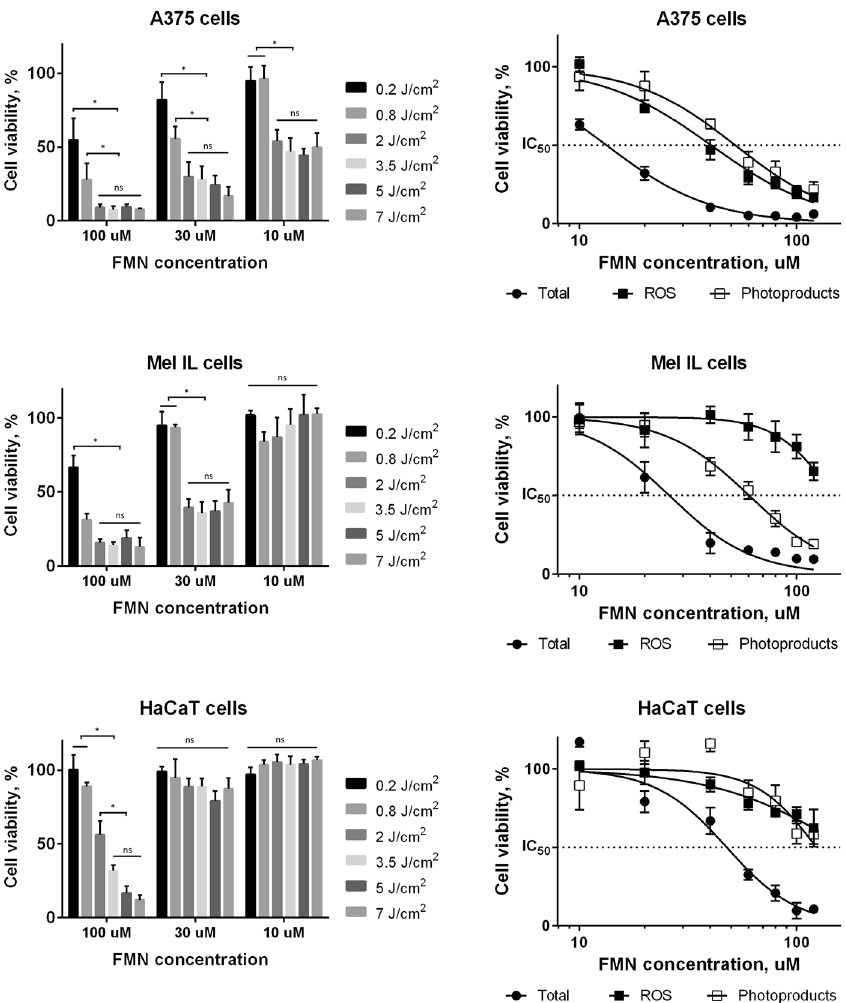
Figure 2. Viability of Mel IL, A375, and HaCaT cells after FMN photoactivation in exposure-dependent (left column) and FMN concentration-dependent at 5 J/cm 2 (right column) manners, 48 h incubation after irradiation with 450 nm. ROS and FMN photoproducts toxicities were measured both separately (black and blank squares, respectively) and in total (black circles). Cells without any treatment were used as controls and taken as 100%. MTT assay, the data are the mean ± SD from at least three replicates. Statistical analysis was performed using non-parametric Mann-Whitney test, * p < 0.05.